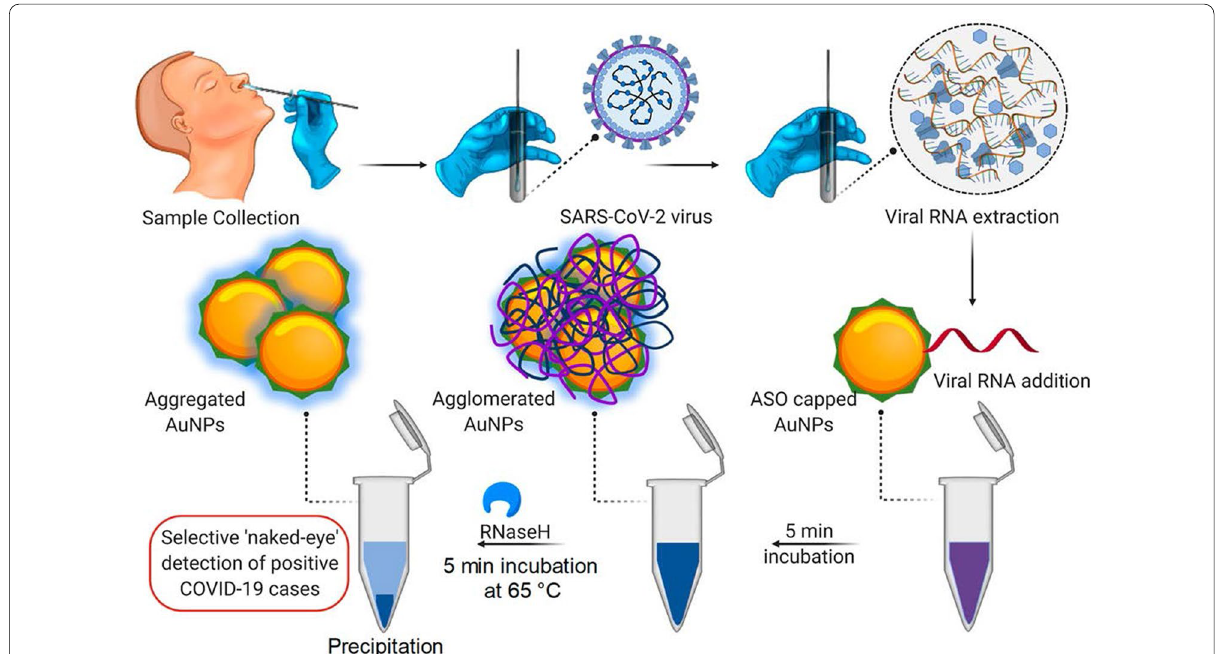
Fig. 3 AuNP-based colorimetric diagnostic system. Selective naked eye detection of SARS-CoV-2 RNA by the ASO-capped AuNPs. Reproduced with permission [60]. Copyright 2020, ACS Nano